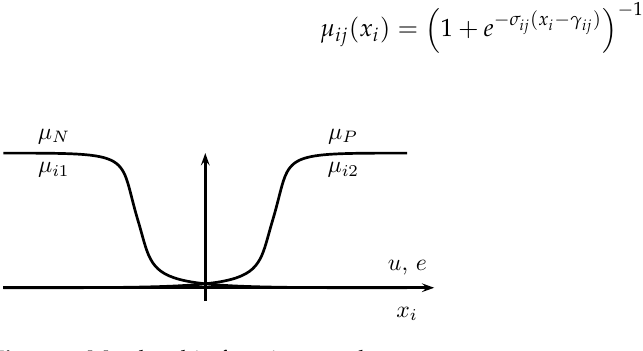
Figure 5. Membership functions